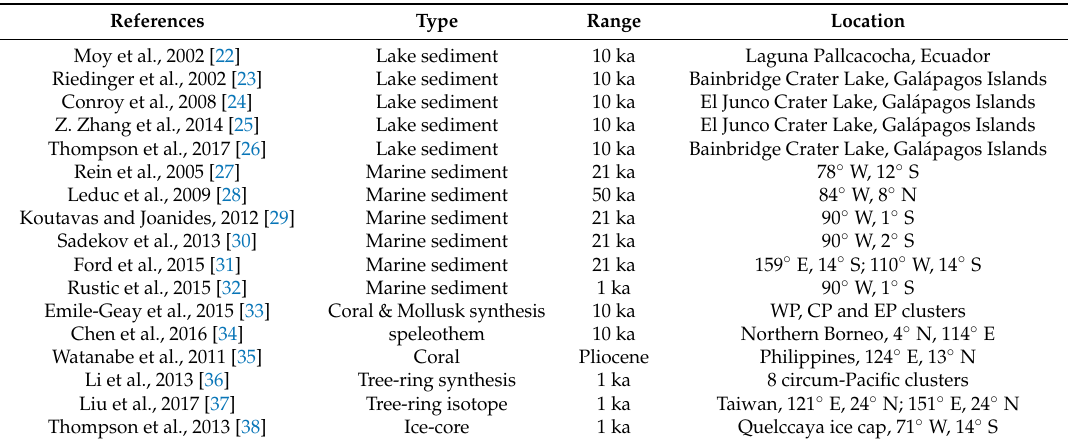
Table 1. The list of paleo ENSO